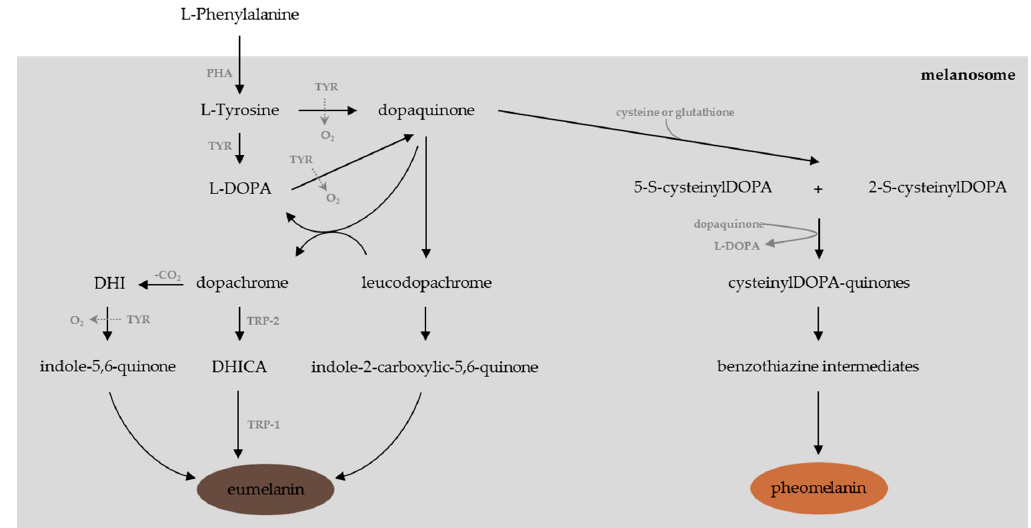
Figure 1. The melanogenesis pathway (adapted from [14,53]).